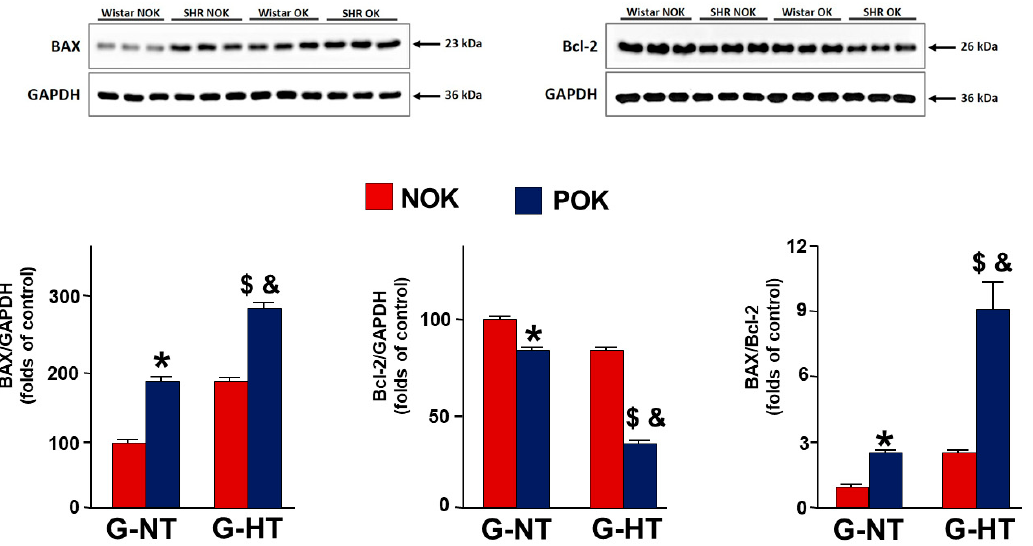
Figure 5. Western blot analysis showing the expression of BAX, Bcl ‐ 2, and the BAX/Bcl ‐ 2 ratio in the POK (post ‐ obstructed kidney) and the NOK (non ‐ obstructed control kidney) in the two groups. Values represent the mean ± SEM. * indicates statistical significance between the POK and NOK in G ‐ NT; $ indicates statistical significance between the POK and NOK in G ‐ HT; & indicates statistical significance in the % difference between the G ‐ HT and G ‐ NT rats.